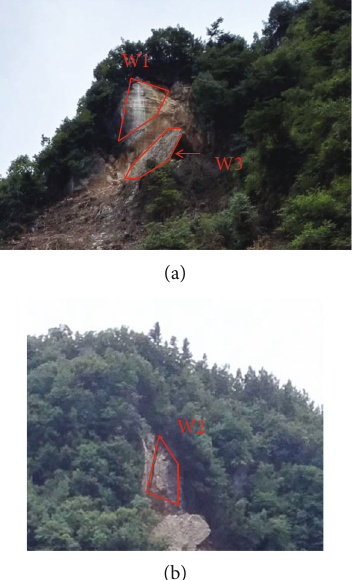
Figure 9: Distribution of dangerous rock masses in the survey area.